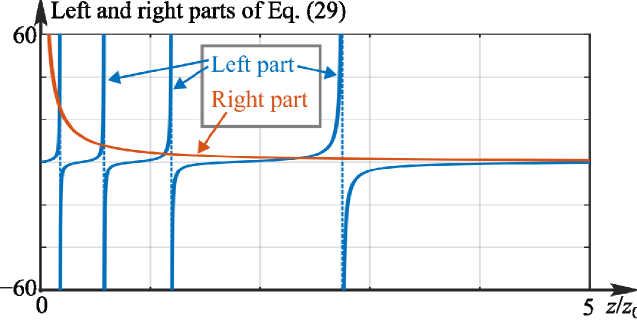
intervals [ z 1, p , z 2, p ].